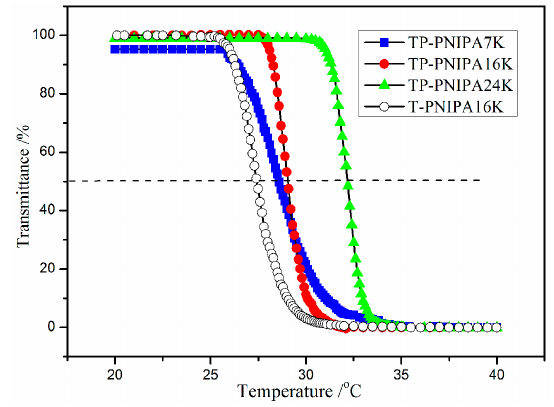
Figure 4. Solution transparency at 500 nm as a function of temperature of PNIPA solutions (0.75 mg/mL).